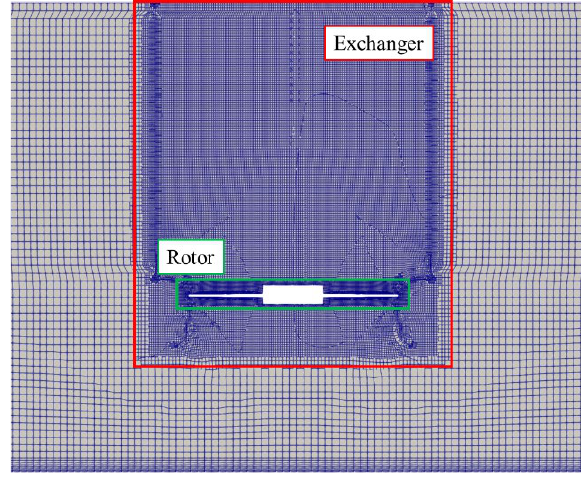
Figure 4. Grid refinements.